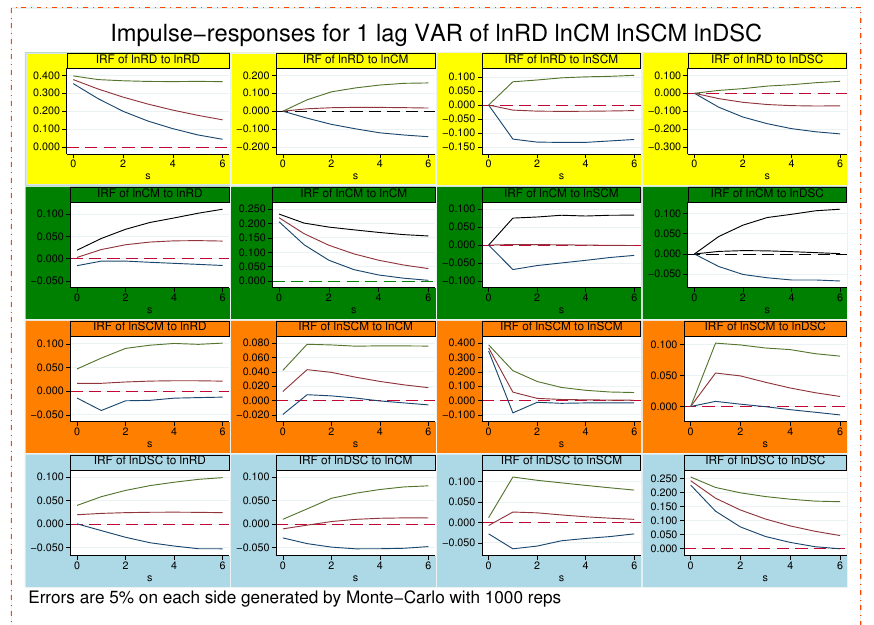
Figure 6. The first row (in yellow) indicates, respectively, impulse responses of R&D innovation to itself (lnR&D), corporate management (lnCM), supply chain management (lnSCM), and debt servicing capacity (lnDSC); the second row (green) indicates, respectively, impulse responses of corporate management to R&D innovation (lnR&D), itself (lnCM), supply chain management (lnSCM), and debt servicing capacity (lnDSC); the third row ( in orange) indicates, respectively, the impulse responses of supply chain management to R&D innovation (lnR&D), corporate management (lnCM),